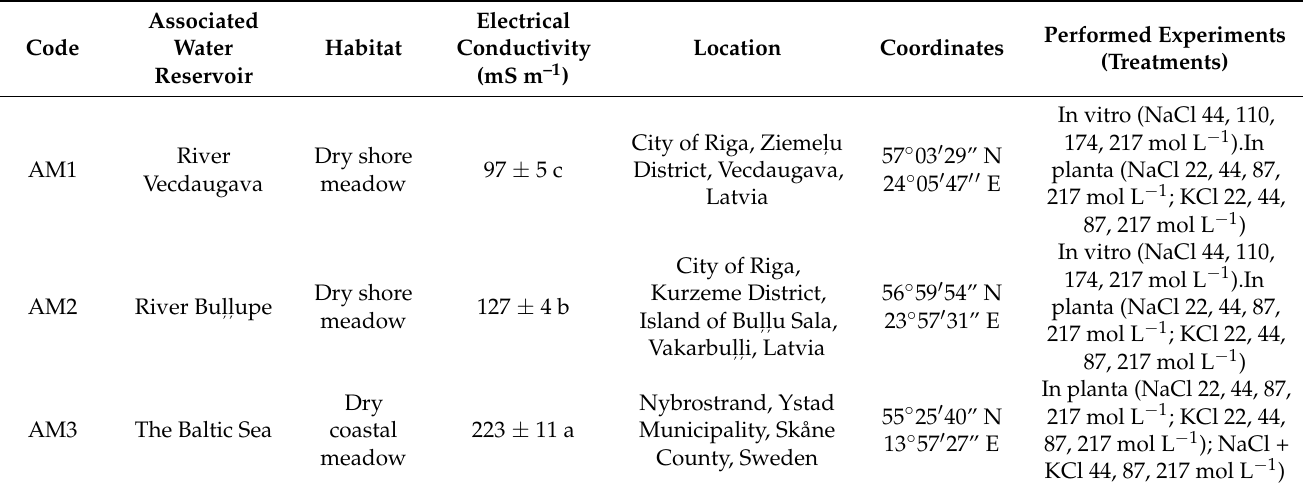
Table 1. Accessions of Armeria maritima used in the present study, characterization of their habitats and experiments